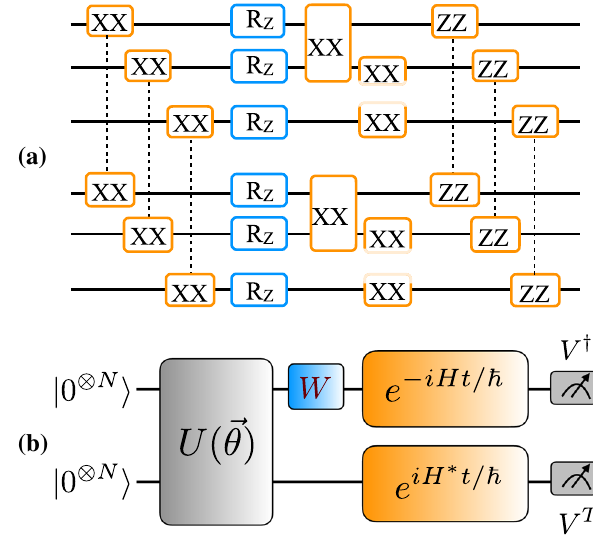
Fig. 12 a Building block of the QAOA circuit that prepares the ther- mofield double state for the transverse Ising model. The XX gate is the local Mølmer–Sørensen gate discussed in the main text, the ZZ gate is the analog of the Mølmer–Sørensen for interactions along the z direc- tion, and R z is a single-qubit rotation around z . The gate angles are found classically. b Measurement protocol for the thermal OTOC. The block U ( θ ) is shown in a . Depth- p QAOA repeats this block p times, with different angles θ 1 , θ 2 , ··· θ